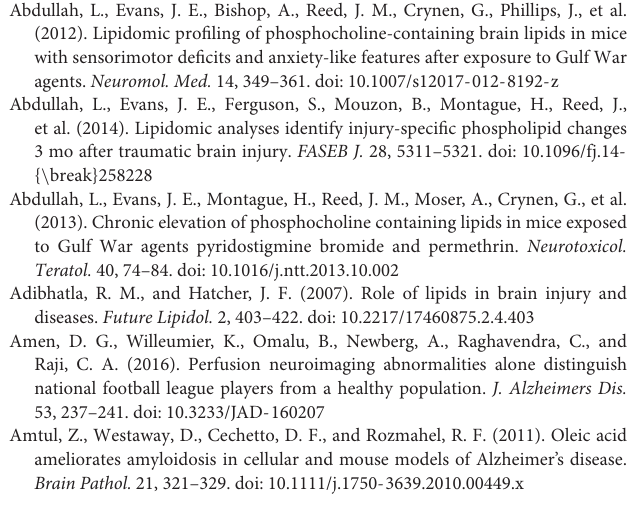
Table S1 | Phosphatidylinositol lipid species in the cortex of r-mTBI mice. Significant changes in individual species containing phosphatidylinositol after repetitive mTBI in hTau mice. Sample size for all groups across all time points is n = 4. All data represent mean µ M per (10 mg) wet weight ± SEM. Individual molecular lipid species were quantified by liquid chromatography/mass spectrometry. Highlighted boxes show significantly regulated levels ( P < 0.01) between repetitive-mTBI/sham mice based on mixed linear modeling regression analysis. Table S2 | Phosphatidylethanolamine lipid species in the cortex of r-mTBI mice. Significant changes in individual species containing phosphatidylethanolamine after repetitive mTBI in hTau mice. Sample size for all groups across all time points is n = 4. All data represent mean µ M per (10 mg) wet weight ± SEM. Individual molecular lipid species were quantified by liquid chromatography/mass spectrometry. Highlighted boxes show significantly regulated levels ( P < 0.01) between repetitive-mTBI/sham mice based on mixed linear modeling regression analysis. Table S3 | Lysophosphatidylethanolamine lipid species in the cortex of r-mTBI mice. Significant changes in individual species containing lysophosphatidylethanolamine after repetitive mTBI in hTau mice. Sample size for all groups across all time points is n = 4. All data represent mean µ M per (10 mg) regulated levels ( P < 0.01) between repetitive-mTBI/sham mice based on mixed linear modeling regression analysis. Table S4 | Phosphatidylcholine lipid species in the cortex of r-mTBI mice. Significant changes in individual species containing phosphatidylcholine after repetitive mTBI in hTau mice. Sample size for all groups across all time points is n = 4. All data represent mean µ M per (10 mg) wet weight ± SEM. Individual molecular lipid species were quantified by liquid chromatography/mass spectrometry. Highlighted boxes show significantly regulated levels ( P < 0.01) between repetitive-mTBI/sham mice based on mixed linear modeling regression analysis. Table S5 | Sphingomyelin lipid species in the cortex of r-mTBI mice. Significant changes in individual species containing sphingomyelin after repetitive mTBI in hTau mice. Sample size for all groups across all time points is n = 4. All data represent mean µ M per (10 mg) wet weight ± SEM. Individual molecular lipid species were quantified by liquid chromatography/mass spectrometry. Highlighted boxes show significantly regulated levels ( P < 0.01) between repetitive-mTBI/sham mice based on mixed linear modeling regression analysis.